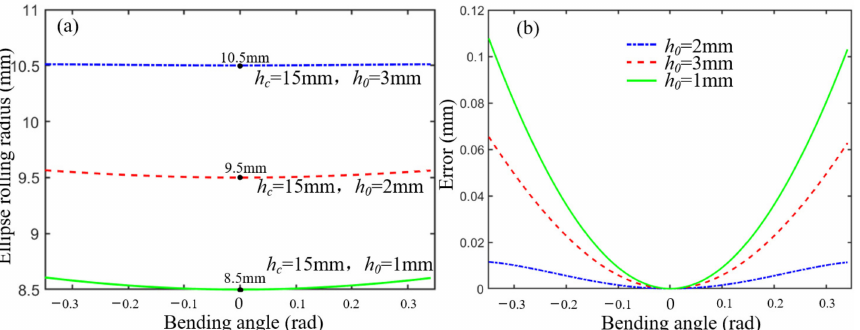
Figure 3. The influence of h 0 on R 0. ( a ) The relationship between the h 0 and ellipse rolling radius. ( b ) The error analysis between R 0 and R in different h 0 .